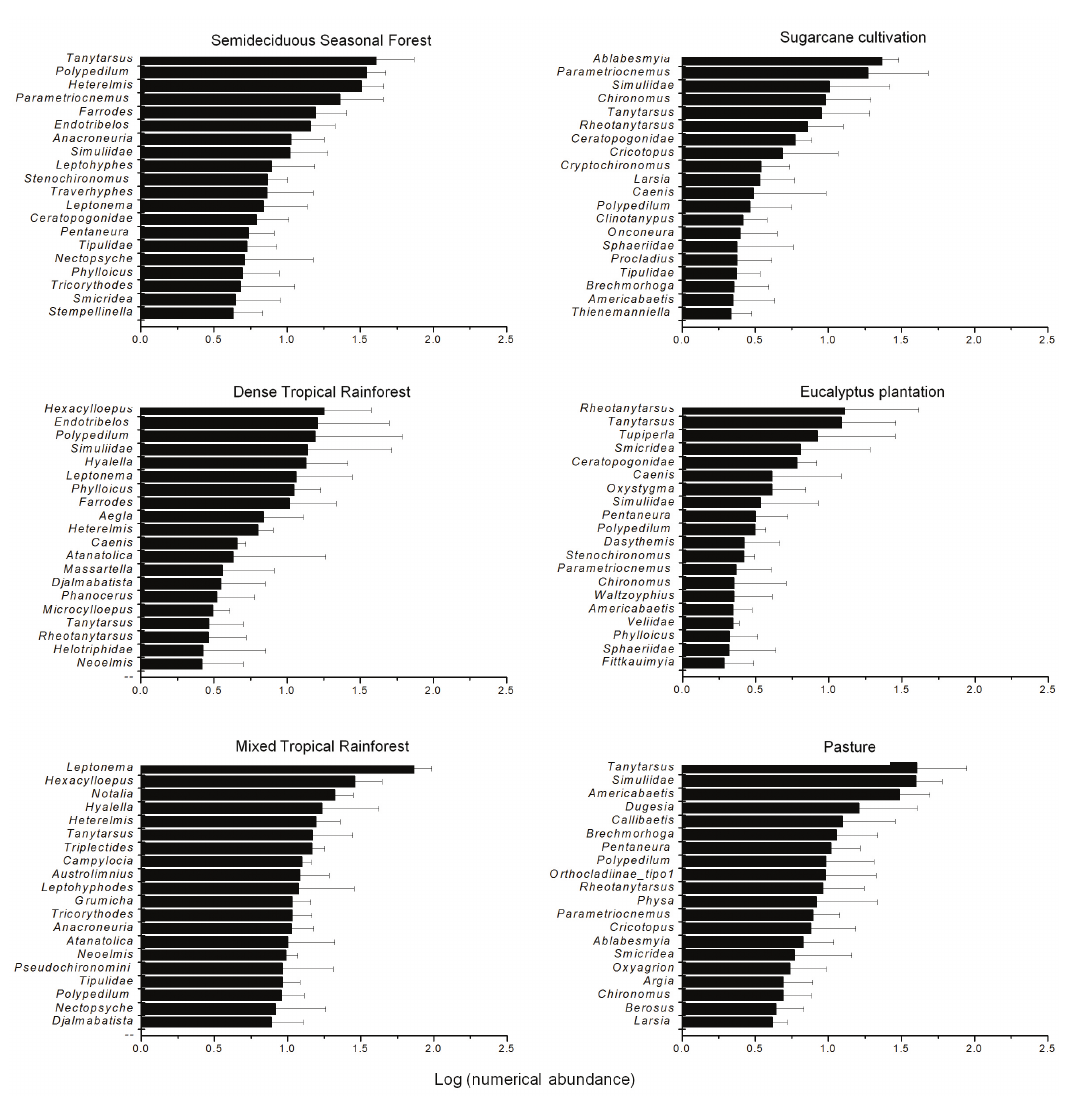
Figure 4. Mean percentages abundance covered in Log and their standard deviations of the twenty most representa- tive taxa in streams of low order in São Paulo